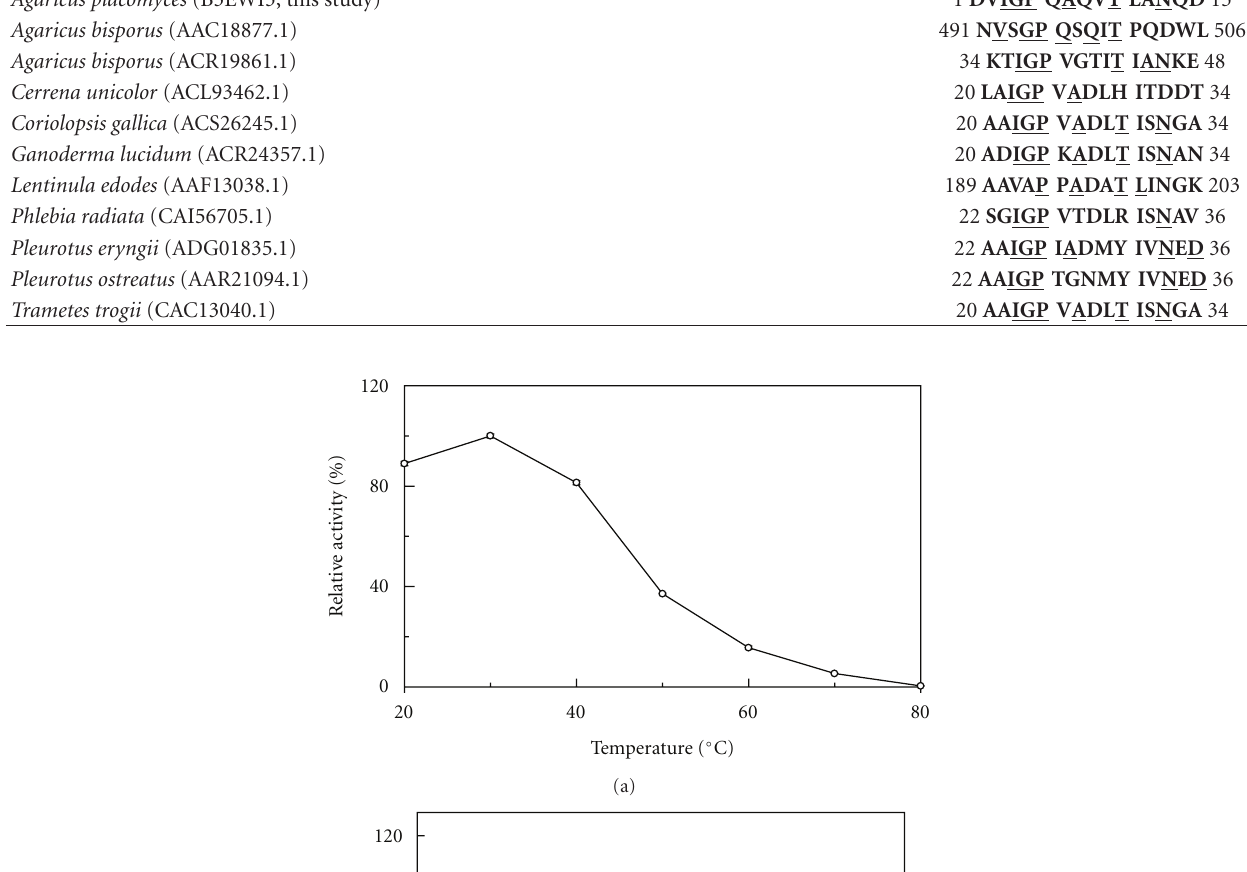
Table 2: Comparison of the N-terminal sequence of A. placomyces laccase with other fungal laccases. Species N-terminal sequence Agaricus placomyces (B3EWI3, this study)